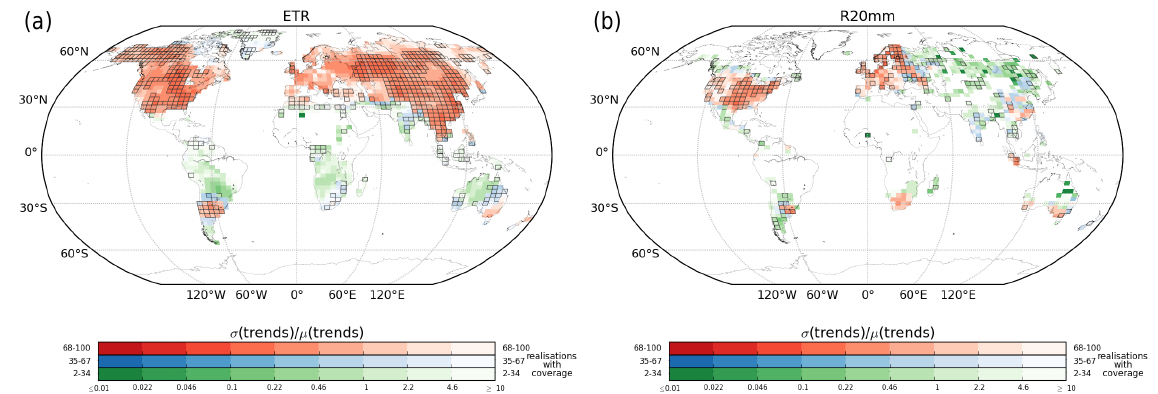
Fig. 19. The standard deviation of the trends divided by the mean trend ( σ/µ ) calculated for the period 1951 to 2010 for ( a ) ETR and ( b ) R20mm using the 25% sub-sampling runs. Green grid boxes are those where 2–34 runs result in a value, blue for 35–67 and red for 68–100. For further details see Fig. 5.